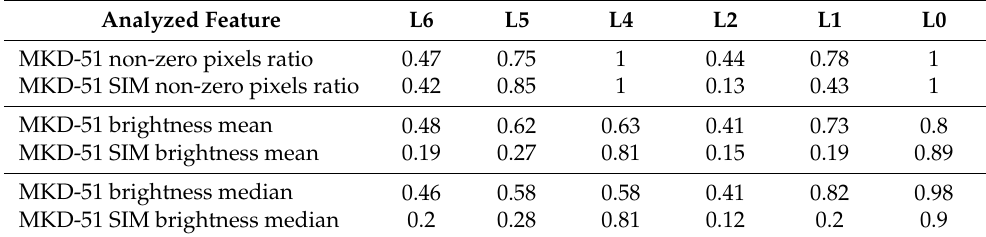
Table 2. Comparison of LED normalized images